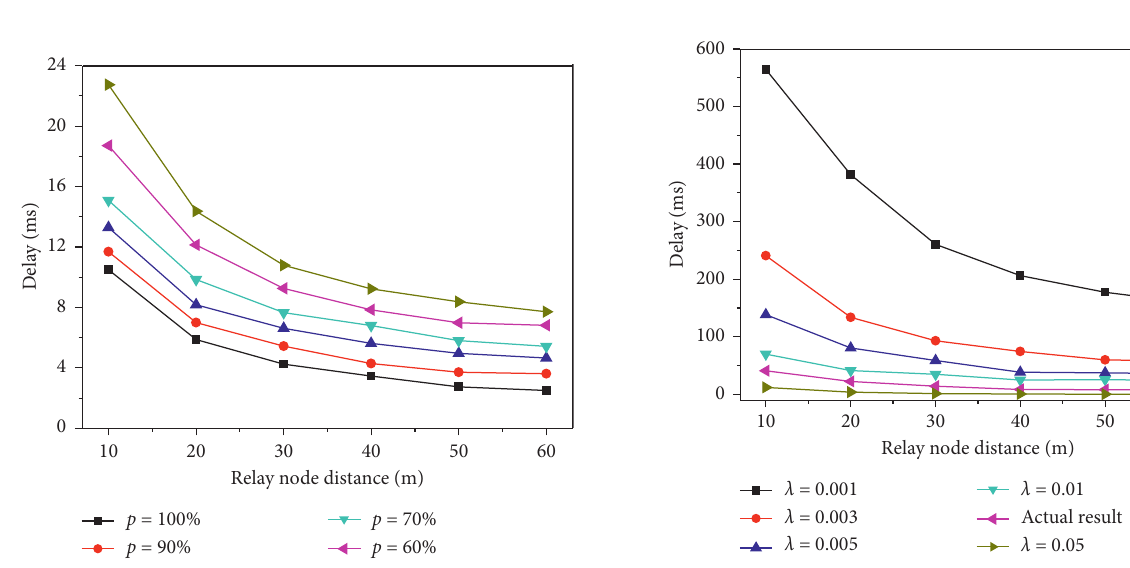
Figure 14: The experimentally measured transmission delay results when p � 100%.